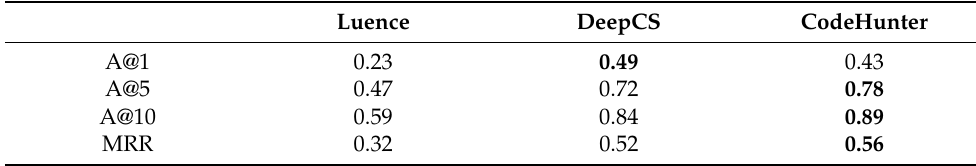
Table 3. The evaluation of Lucene, DeepCS and CodeHunter search